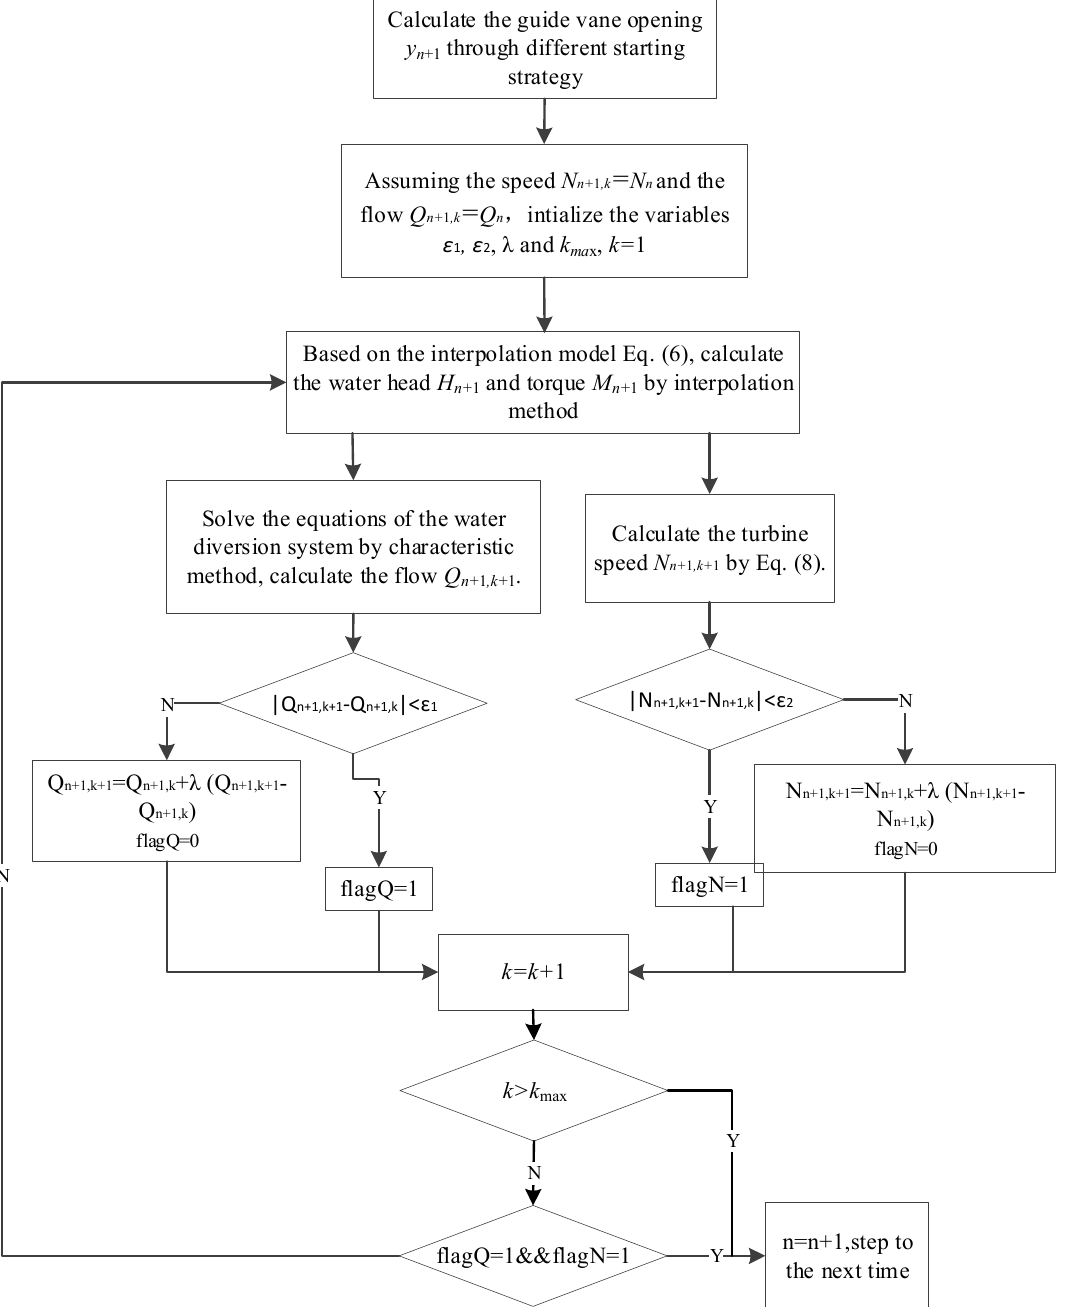
Figure 6. The water flow and turbine speed calculation of the PTGS.